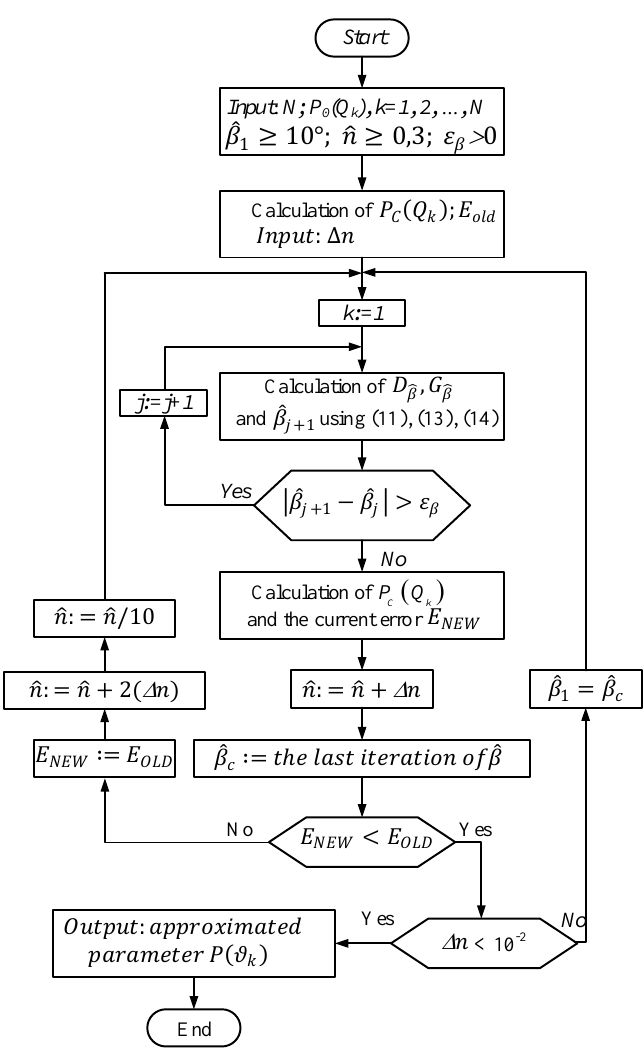
Figure 4. Algorithm for parameters determination of the approximation radiation pattern.